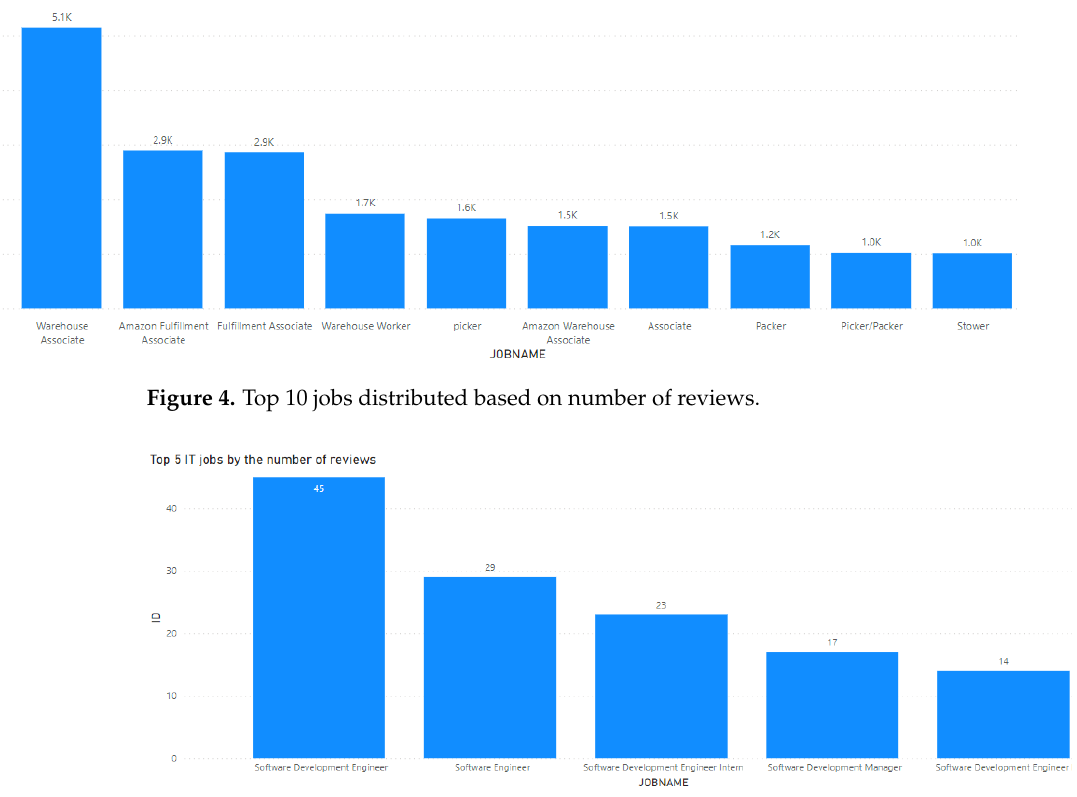
Figure 5. Top 5 jobs distributed based on number of reviews.